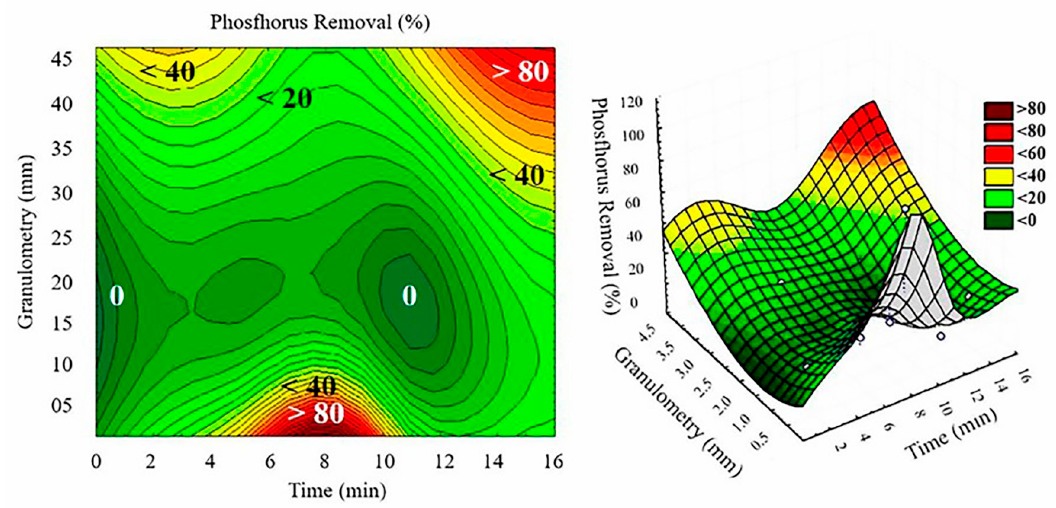
Figure 13. Different percentages of removal of the phosphorus element as a function of the granulometric variation and the contact time of the iron ore